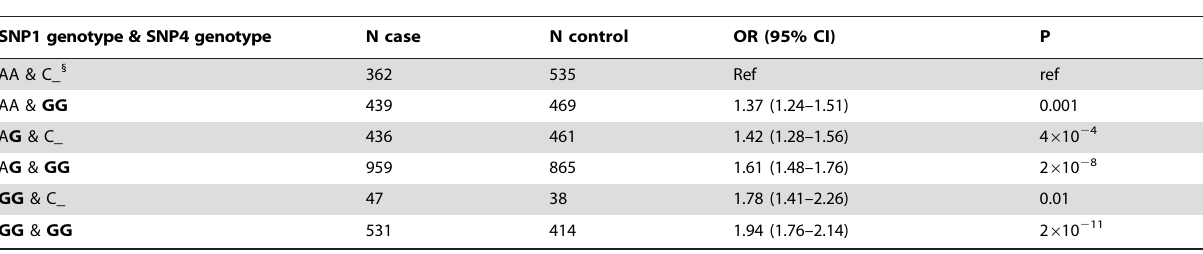
Table 6. Additive effects of SNP1 and SNP4